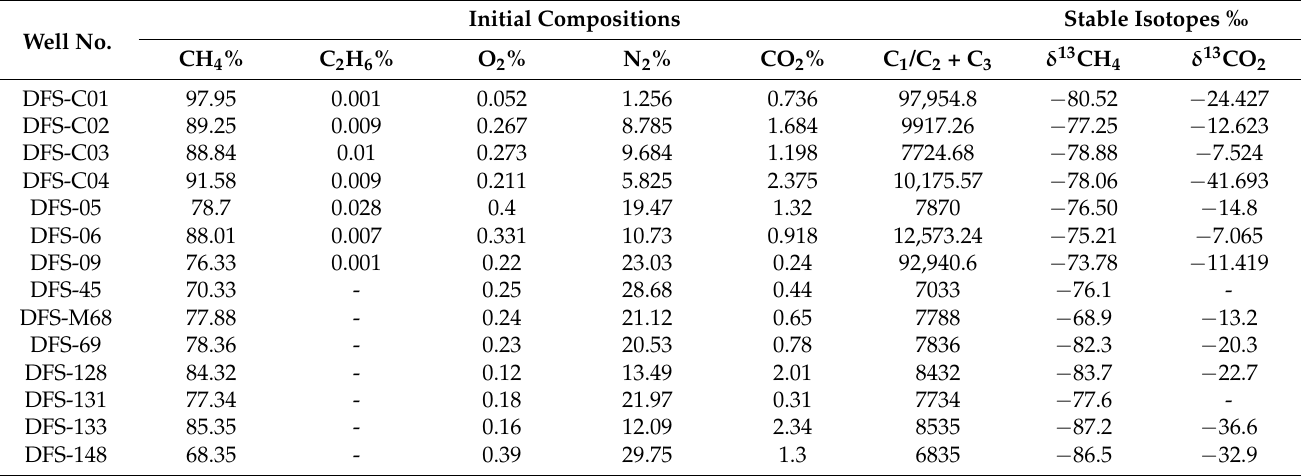
Table 4. Gas compositions and carbon isotopes analysis.